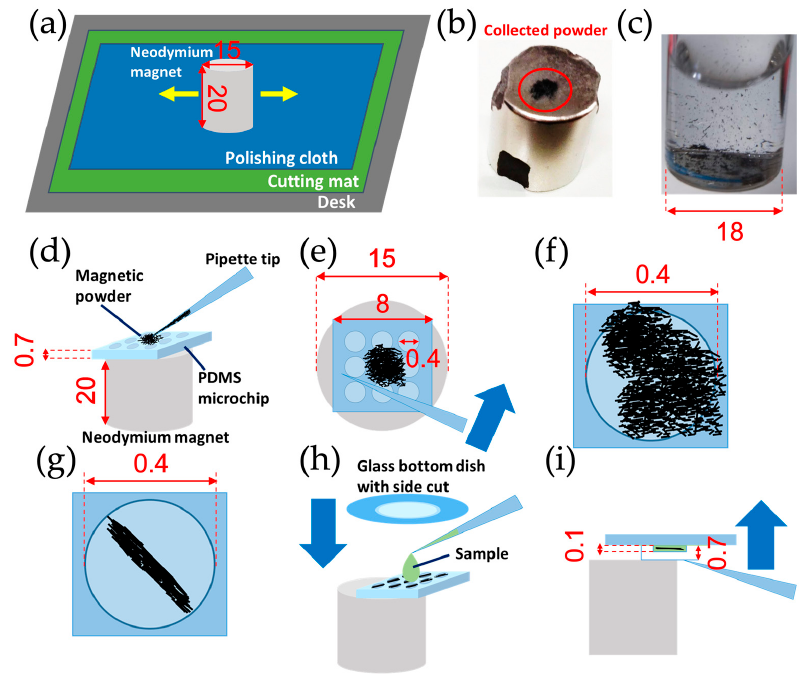
Figure 1. Schematic diagram of the fabrication process for the MMSB. All dimensions are in mm. ( a ) Place the cutting mat on the desk, place the polishing cloth on the cutting mat, and rub the neodymium magnet, SUS304, or the magnetic sheet. ( b ) Collect the powder adhering on the neodymium magnet in one place with latex gloved fingers. The part surrounded by red is the powder. ( c ) Pick up the powder collected with latex gloved fingers and disperse the powder in alcohol. ( d ) Put the PDMS microwell on the neodymium magnet. The alcohol dispersed with the powder is sucked up with a micro-pipette and injected onto the PDMS microchip. ( e ) Spread the powder with the pipette tip to put the powder into the microwell. ( f , g ) If there is too much powder in the microwell, flush the excess powder with alcohol while holding the PDMS microchip against the neodymium magnet. ( h ) Bring the PDMS microchip to the end of the neodymium magnet. Put cell suspension ( C. reinhardtii suspension) on the PDMS microwell. Then press a glass bottom dish with only the bottom cut out over the PDMS microchip. ( i ) Lift the PDMS microchip and the glass bottom dish with the pipette